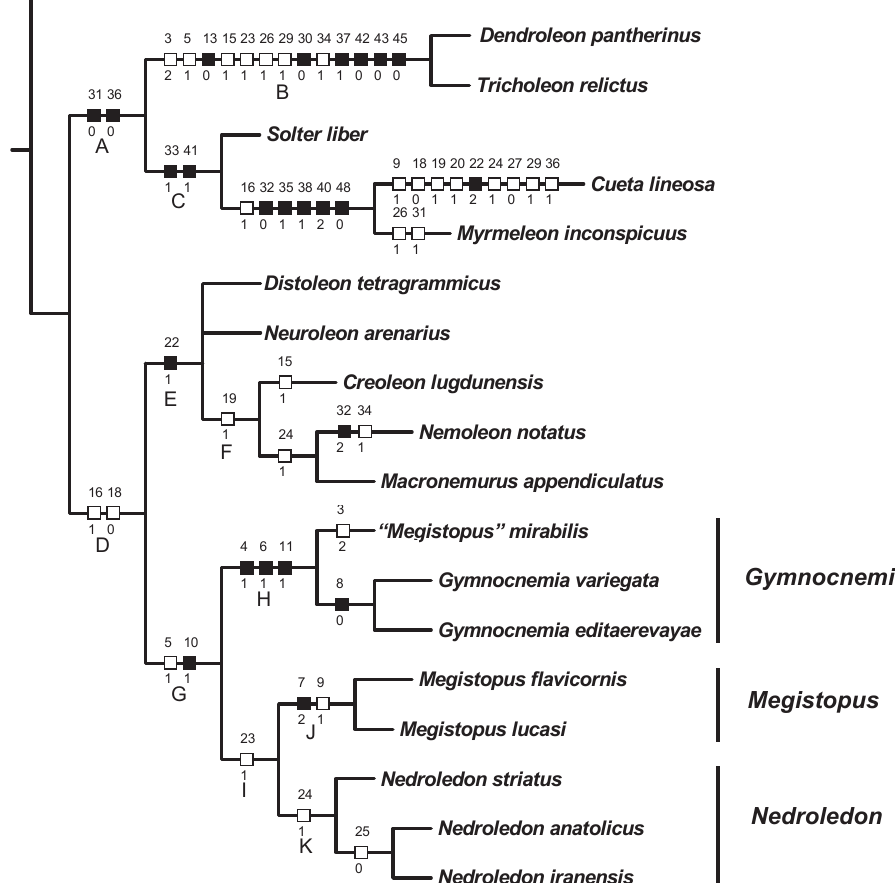
Figure 10. Preferred tree of the two most parsimonious trees (83 steps, C.I. 0.687) obtained in the analysis. Black squares indicate nonhomoplasious apomorphies, white squares homoplasious ones. Letters indicate clades discussed in the